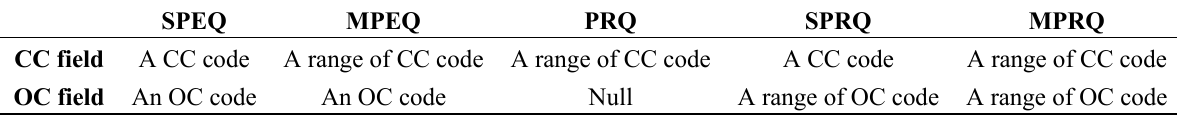
Table 3. The query requirements of SPEQ, MPEQ, PRQ, SPRQ and MPRQ.